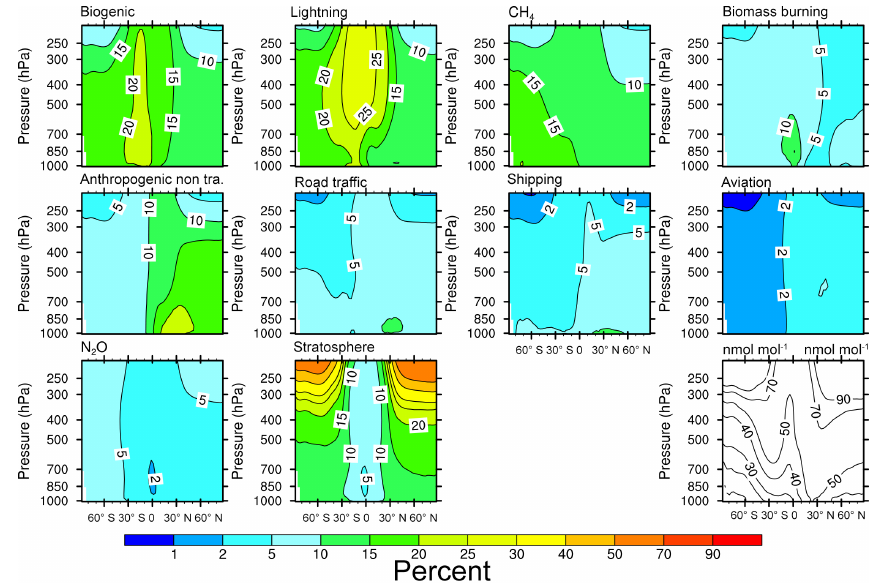
Figure 4. Annual mean contributions [%] of 10 emission sectors to the simulated ozone volume mixing ratios. The simulated ozone volume mixing ratio is shown in the lower right